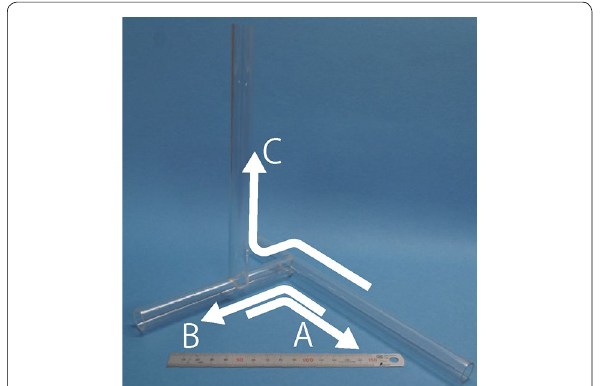
Fig. 12 Experimental PMMA piping system